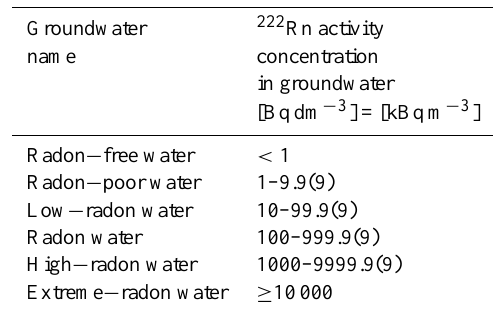
Table 1. Groundwater classification based on 222 Rn content (ac- cording to Przylibski,